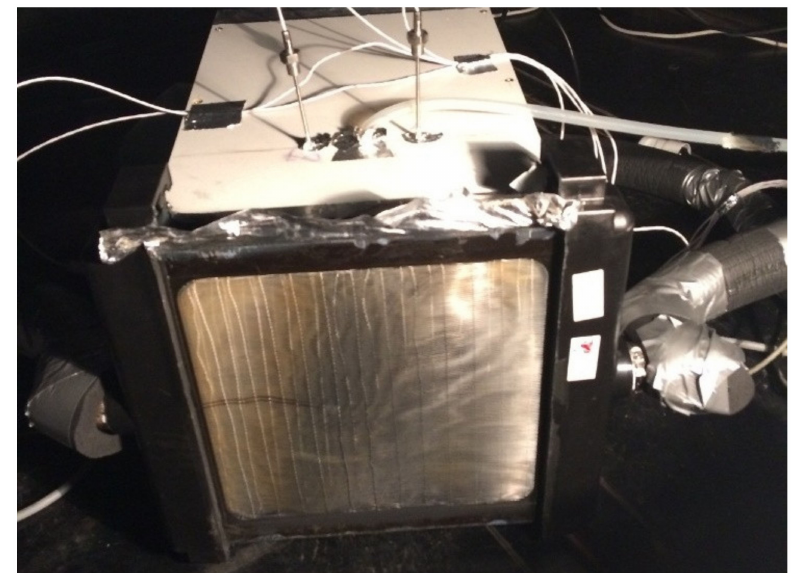
Figure 4. Front side of the heat exchanger connected to the entrance of the wind tunnel after injection of 200 g of the test